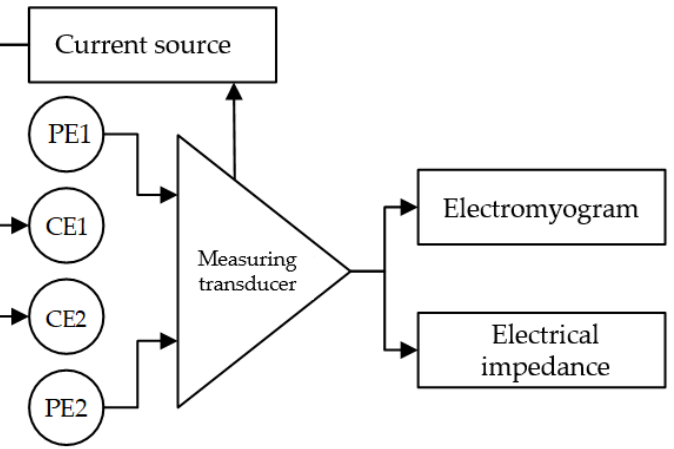
Figure 2. Simultaneous acquisition of EI and EMG signals (PE, potential electrode; CE, current elec-